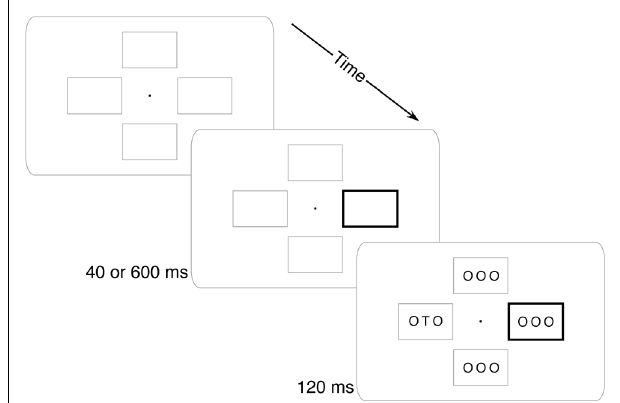
FIGURE 1 | Example trial. Four placeholder boxes and a central fixation dot were always visible. At the beginning of each trial, one box would darken. After either 40 or 600 ms, the stimulus array would appear and participants would report whether a “T” or an “F” was